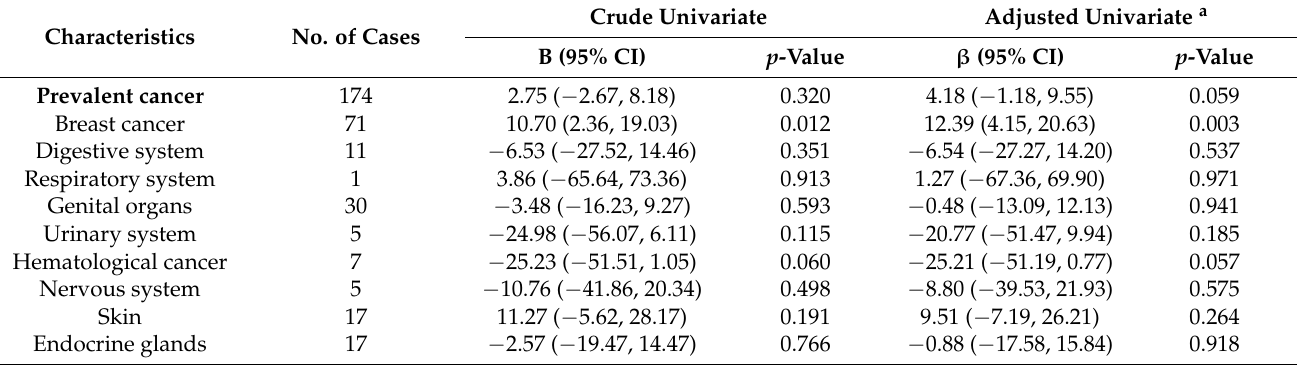
Table 2. Linear regression models examining association between prevalent cancer and